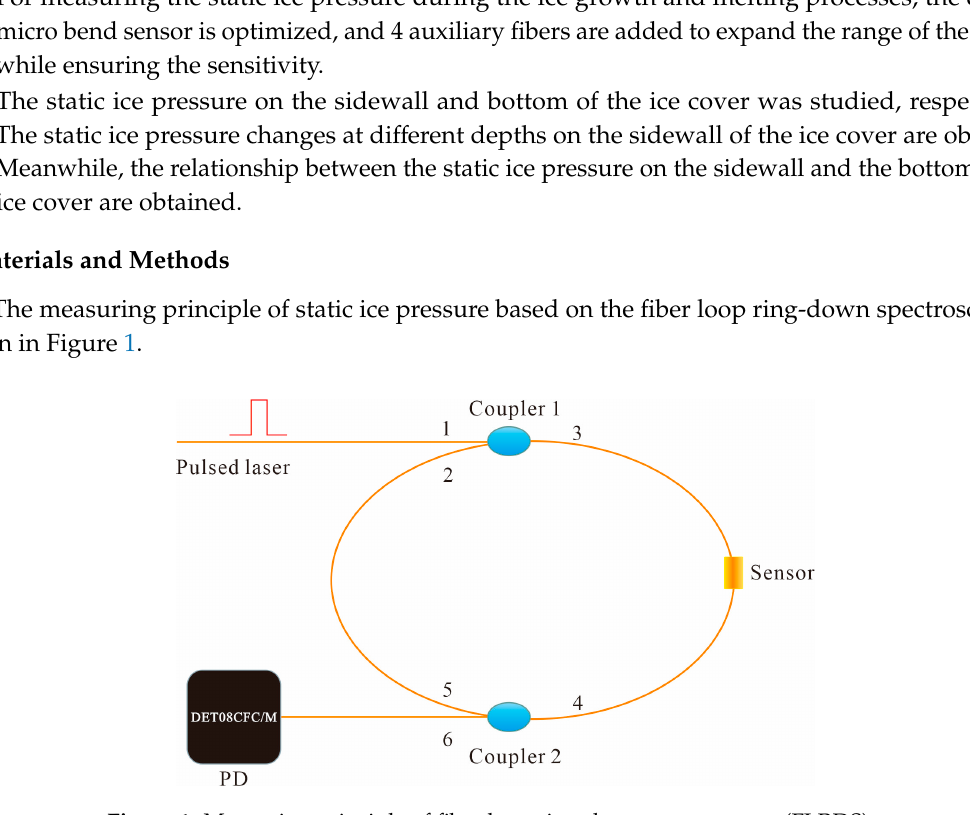
Figure 1. Measuring principle of fiber loop ring-down spectroscopy (FLRDS).